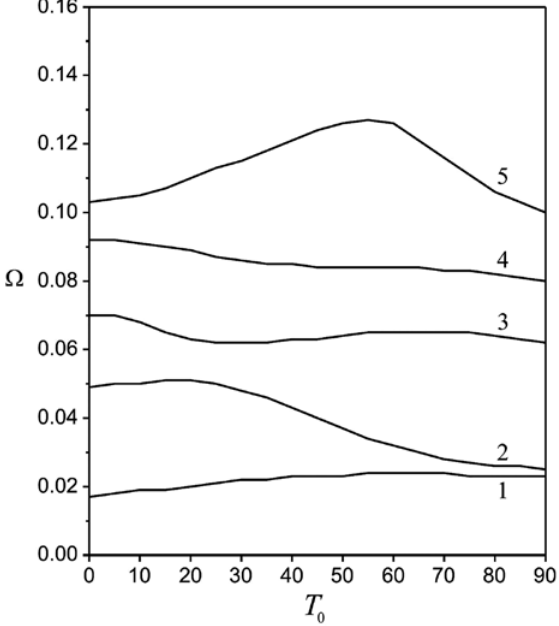
Figure 13: Frequency parameter Ω versus T five modes of the soft simply supported E-glass/epoxy [  〈 T circular laminate.